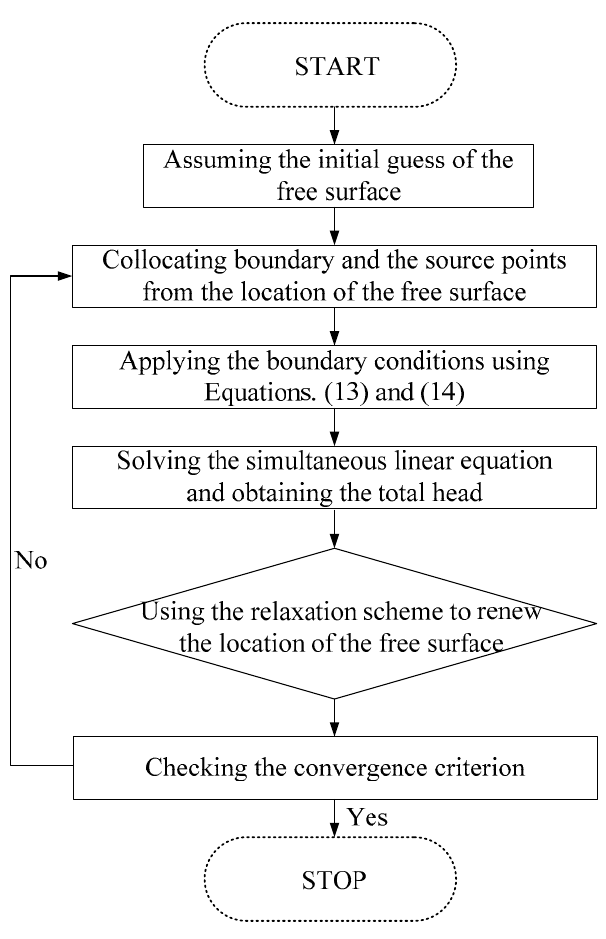
Figure 2. Flow chart of solving nonlinear free surface using the relaxation scheme.